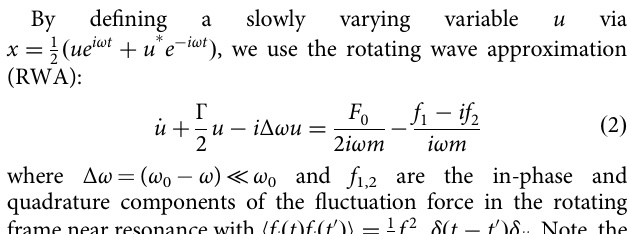
b u u k (cid:2) k (cid:2) 1 is exaggerated for illustration. c LHO position power spectral density